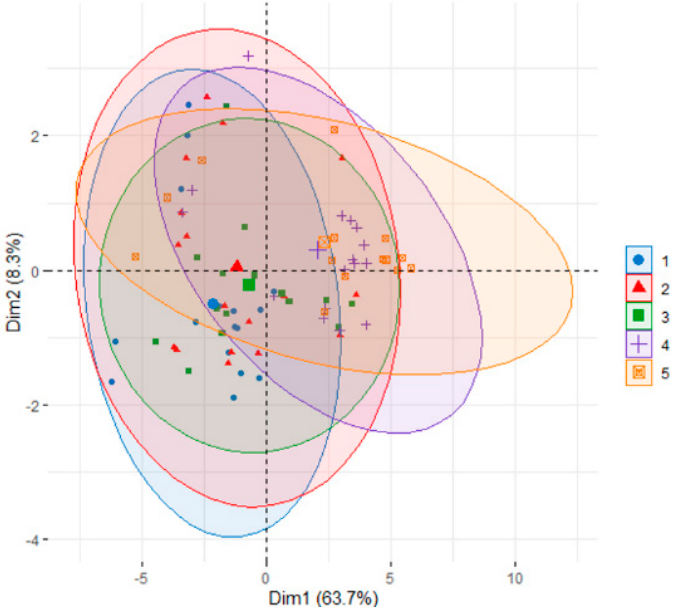
Figure 5. Degree of implementation of projects in enterprises by markets. Source: own research for N = 79 [123]. Where 1 is global market, 2 is European market, 3 is foreign markets, 4 is national market, 5 is local, regional market.